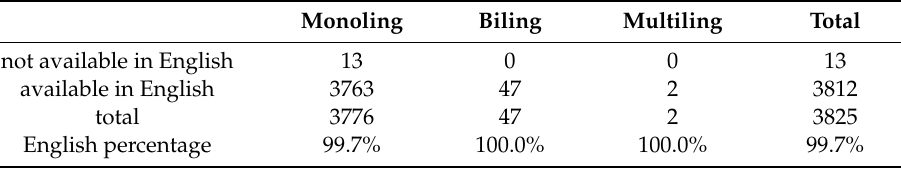
Table A28. English language availability (ie).